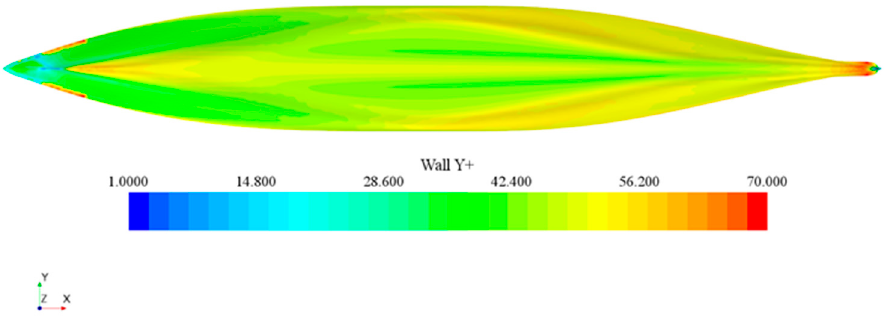
Figure 1. Wall Y+ values on the hull bottom Fr = 0.15.